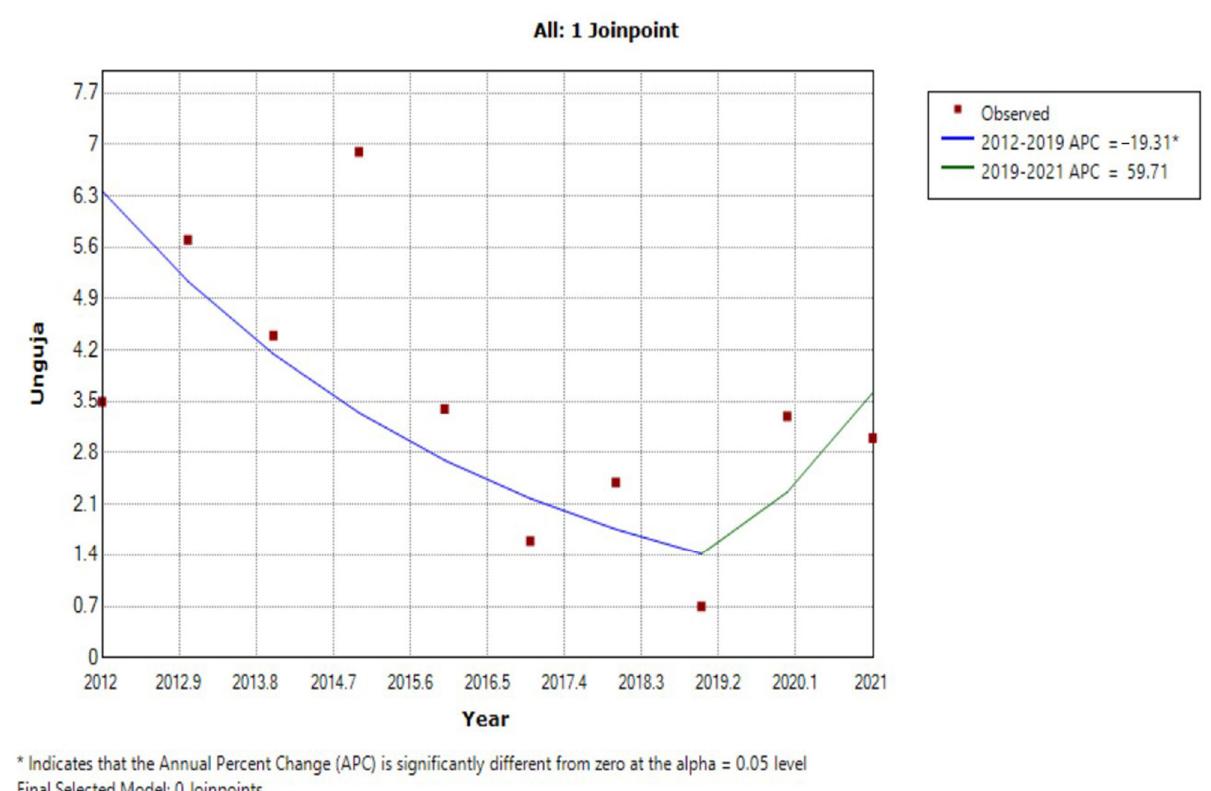
Figure 3. JRM for the trend in schistosomiasis prevalence in Unguja from 2012 to 2021. In Pemba, schistosomiasis prevalence decreased at a mean rate of − 22.2% per year from 2012 to 2017 (Z = − 3.0, p = 0.029, p < 0.05), and then decreased at − 8.6% per year from 2017 to 2021 (Z = − 0.8, p = 0.474, p > 0.05). The schistosomiasis infection rate showed an inflection point in 2017, dividing the data into two time periods, 2012–2017 and 2017–2021. The JRM curve first decreased rapidly, followed by a more gradual decline. The rate of schistosomiasis prevalence decrease from 2012 to 2017 was significant (APC = − 22.2%, p < 0.05), while that from 2017 to 2021 was not (APC = − 8.6%, p > 0.05) (Figure 4).